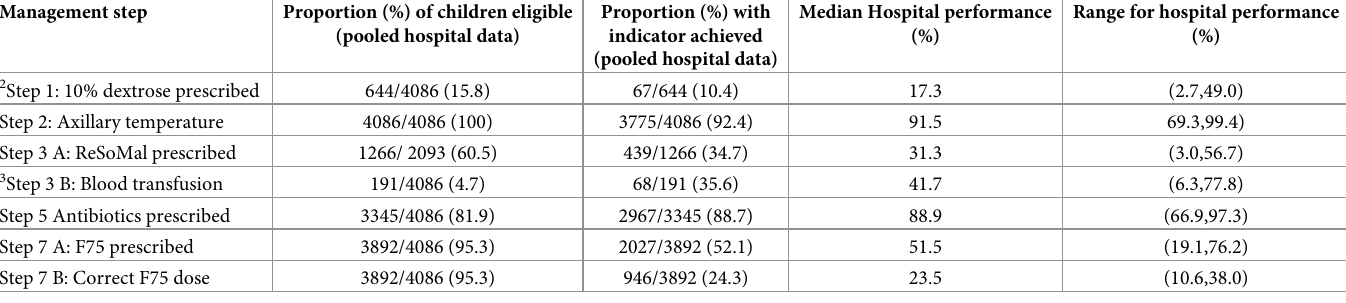
Table 5. Summary performance of clinicians in the management of SAM (group A&B) among children aged 6 to 59 months admitted to CIN hospitals 1 between December 2013 and November 2016. Management